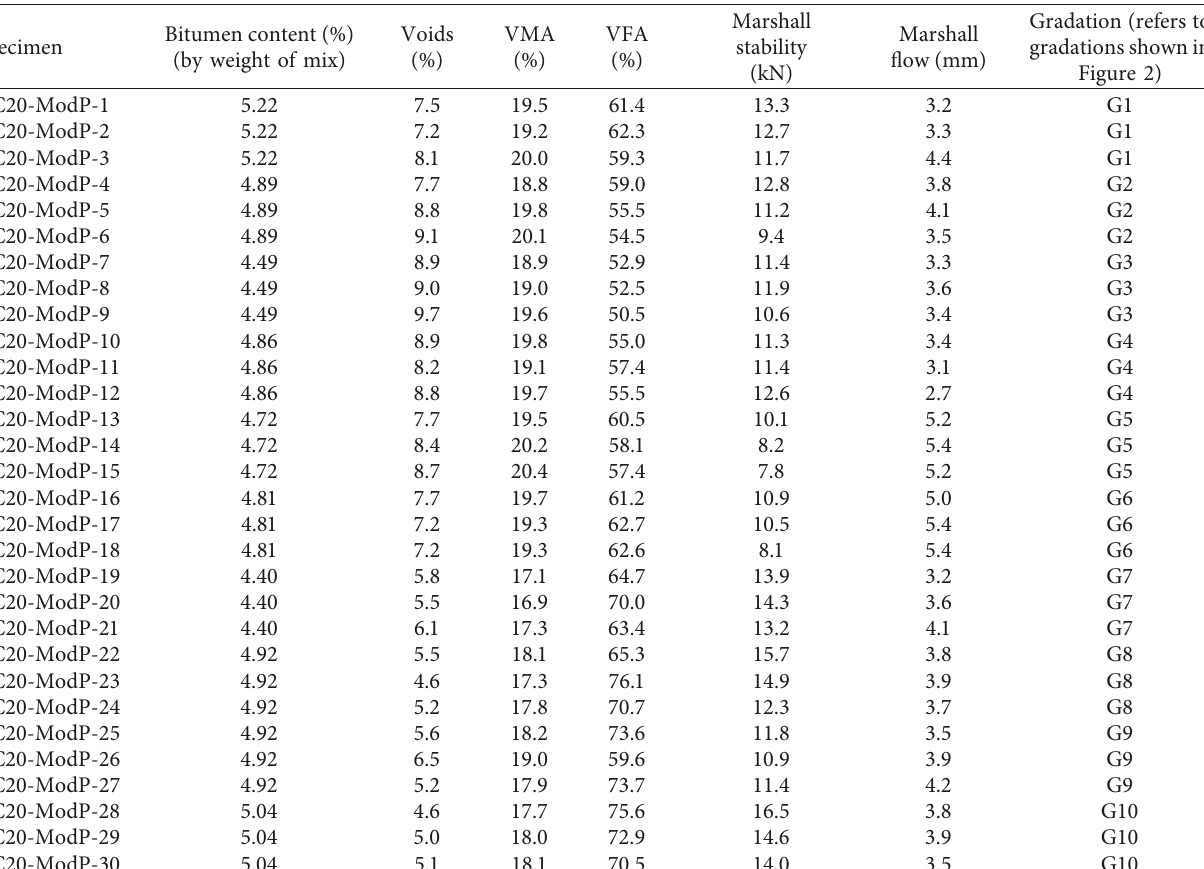
Table 5: Properties of AC20-ModP